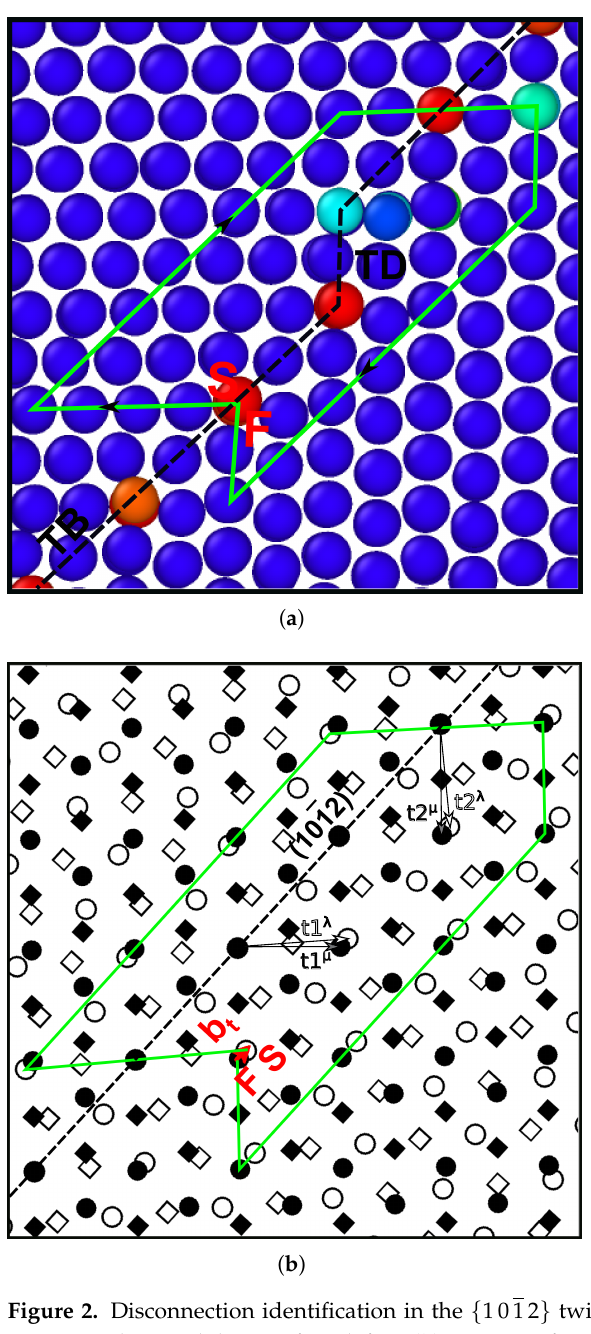
Figure 2. Disconnection identification in the { 1012 } twin interface in Ti. ( a ) A closed circuit is constructed around the interface defect. ( b ) Using a reference pattern showing the lattice positions from both crystals coinciding at the original interface position, a reference circuit with closure failure is constructed. The closure failure gives the Burgers vector and step height of the